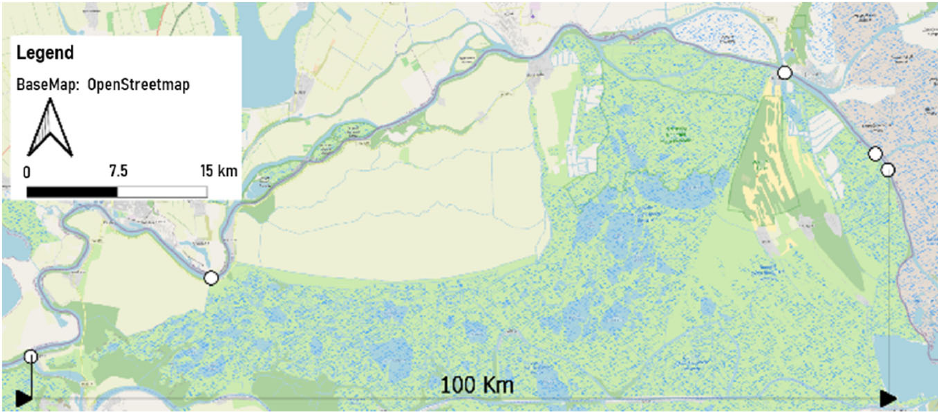
Figure 2. The area included in the grid processing.